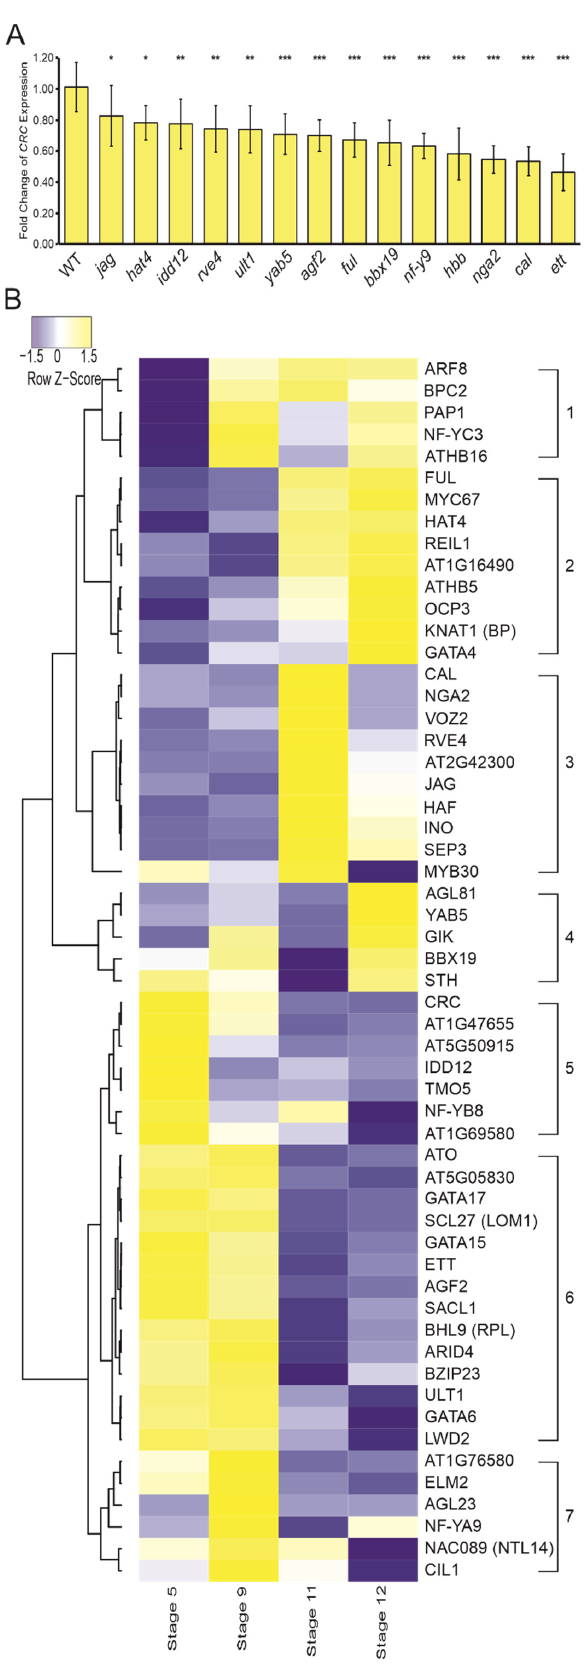
Figure 3. Quantitative effect of regulator mutants on CRC expression and digital gene expression analysis of putative CRC regulators. ( A ) CRC expression in candidate mutant lines in relation to